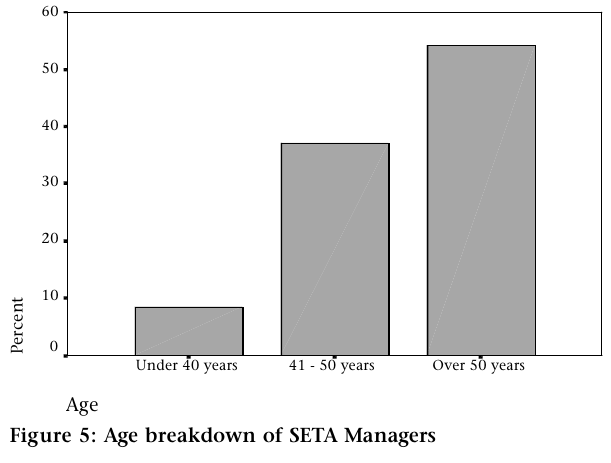
Figure 5: Age breakdown of SETA Managers